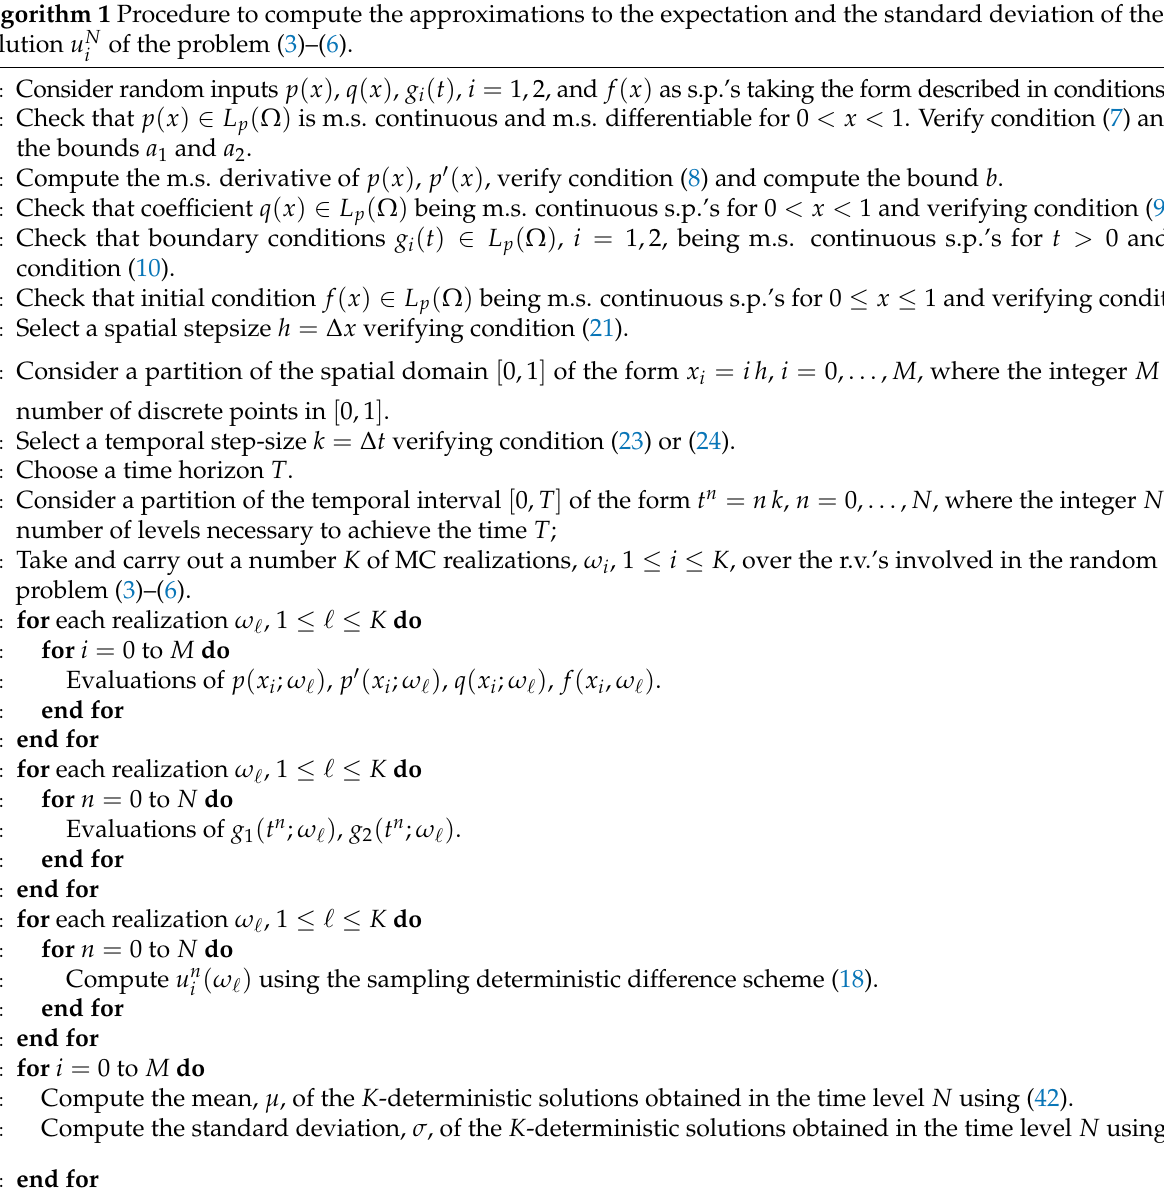
Algorithm 1 Procedure to compute the approximations to the expectation and the standard deviation of the numerical solution u N of the problem i